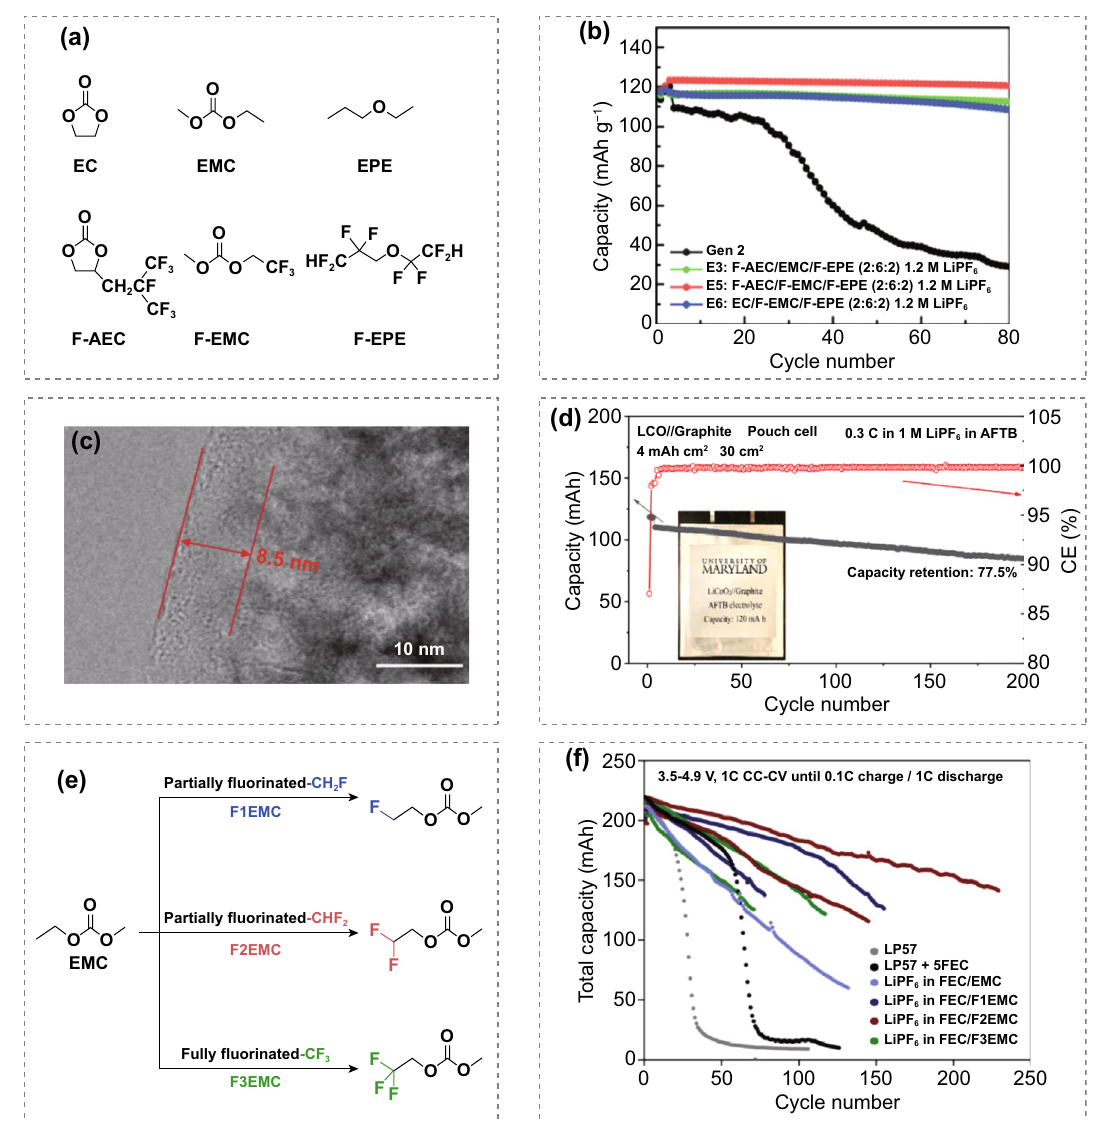
Fig. 6 a Chemical structure of the baseline carbonate, ether fluorinated counterparts. b Cycling capacity retention of Li 4 Ti 5 O 12 /LiNi 0.5 Mn 1.5 O 4 cells with baseline electrolyte and fluorinated electrolytes at 55 °C. Copyright from Ref. [100]. c TEM images of cycled LiCoO 2 electrode and d cycle performance of the single-crystalline LiCoO 2 //graphite pouch cell in the fluorinated electrolyte. Copyright from Ref. [3]. e Molecular structures of fluorinated ethyl methyl carbonate solvents. f Cycling behavior of LiNi 0.5 Mn 1.5 O 4 //graphite pouch cells using different electrolytes with 1 M main salt and FEC/fluorinated-EMC = 3/7 volume ratio at 1C charge/discharge. LP57: 1 M LiPF 6 in ethylene carbonate/ethyl methyl carbonate (EC/EMC, 3/7 by volume). LP57 + 5FEC: LP57 + 5% FEC (by weight). Copyright from Ref.